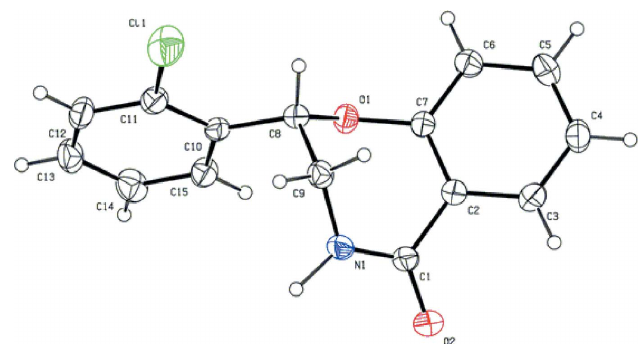
Figure 1 Molecular structure of the title compound with displacement ellipsoids drawn at 50% probability level.